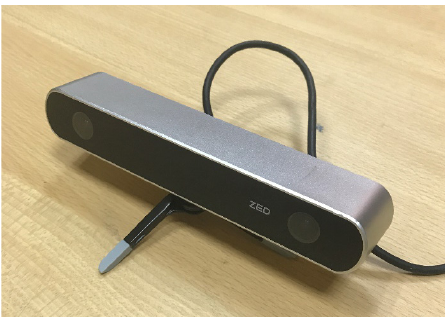
Figure 1. ZED Stereo Camera